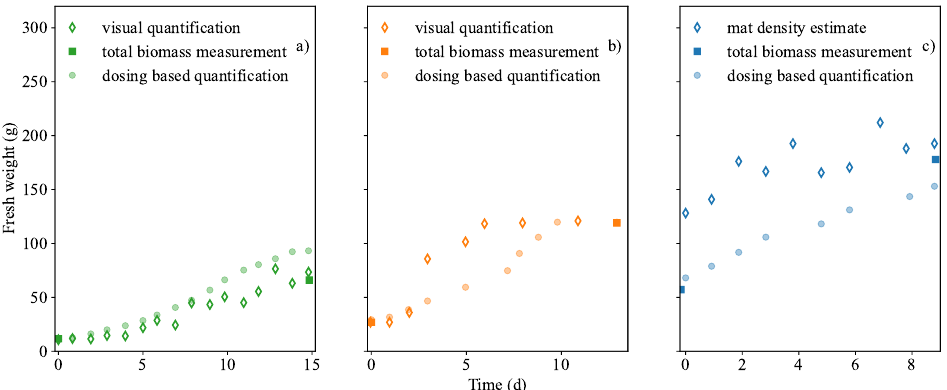
Figure 3. Biomass quantification methods were compared. Visual based estimation (photo pixel analysis) of the biomass coverage in ( a ) Run 1 and ( b ) Run 2. Biomass density determinations were based on physical mass measurements in a known area in ( c ) Run 3. Additionally, biomass quantification based on the acid dosing was included in ( a – c ) . All measurement techniques were compared against the available initial and final actual mass